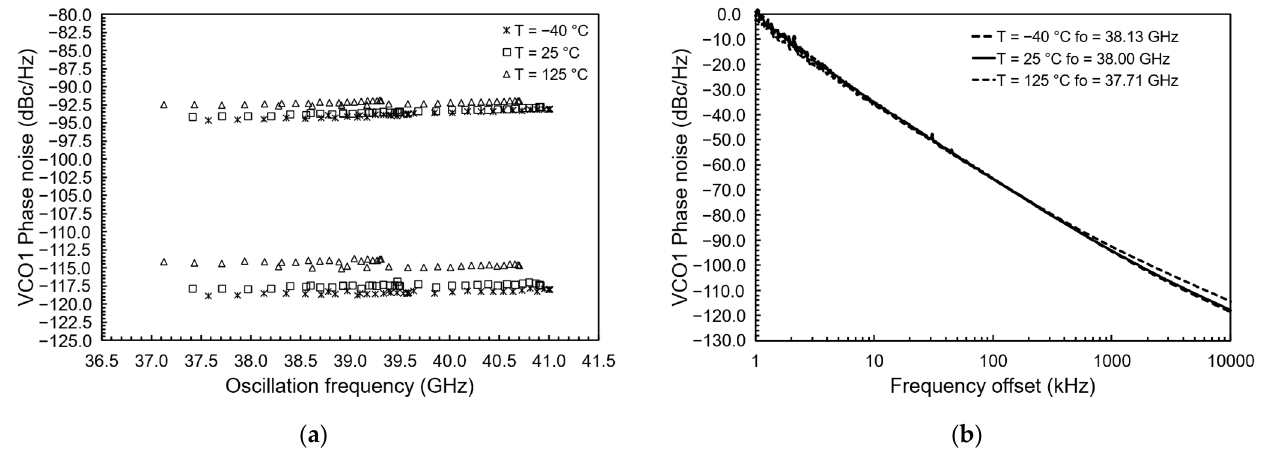
Figure 9. Measured VCOs single-sideband phase noise: ( a ) at 1 and 10 MHz frequency offset at three different temperatures; (b ) vs. frequency offset at three different temperatures.